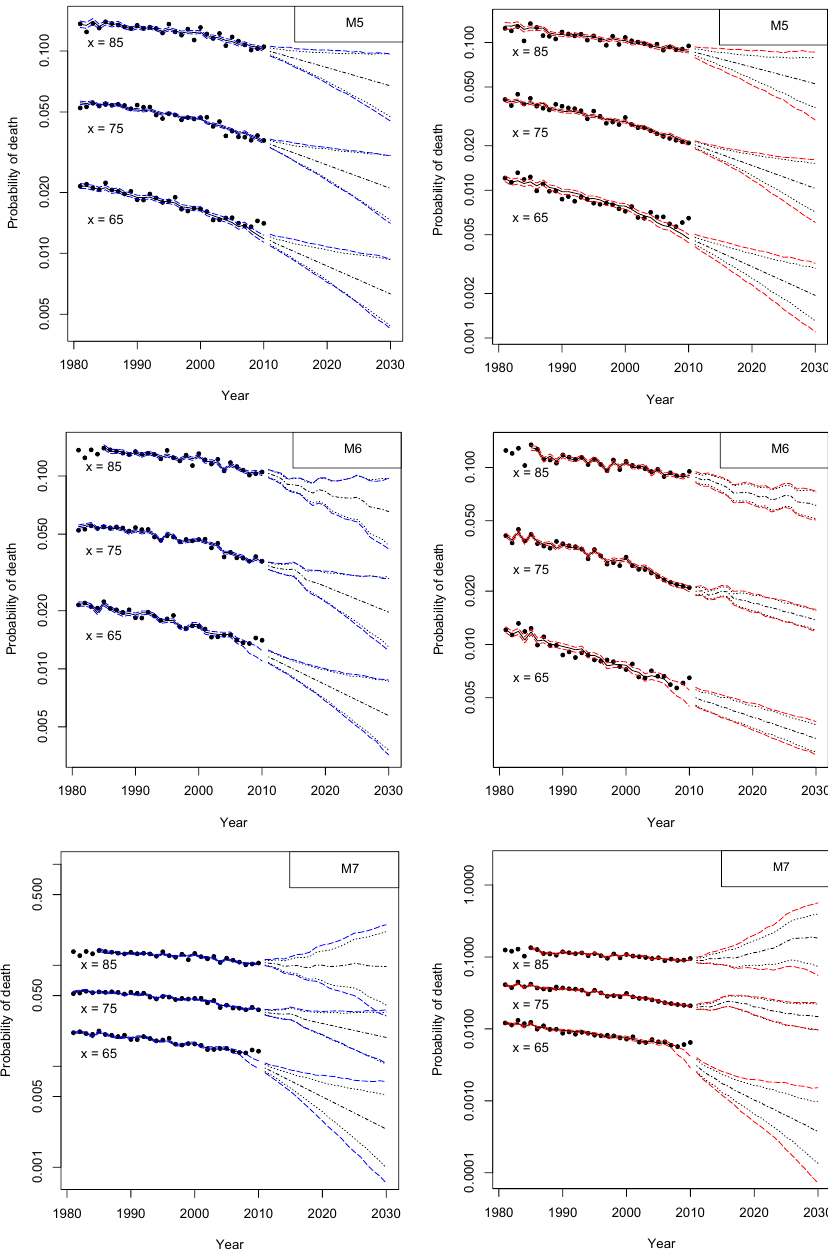
Figure 16. 95% prediction intervals for the probabilities of death at ages x = 65, x = 75 and x = 85 for models M 1 – M 7 , fitted to males ( left panels) and females ( right panels) for ages 60–89 and the period 1981–2010 (thick dots). Solid lines denote the corresponding fitted rates and dot-dashed lines depict the 95% confidence intervals including parameter uncertainty. For the projection period 2011–2030, the central forecast values are given by dashed lines. Dashed lines and dot lines show the 95% prediction intervals with and without parameter uncertainty,